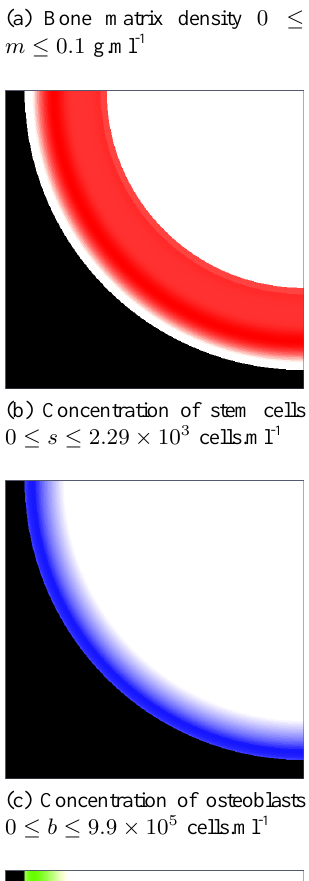
Fig. 3: One quarter of the domain where the black area corresponds to the bone ( m 0 ( x, y ) = 0 . 1 g.ml -1 ) and cellular cluster ( s 0 ( x, y ) = 10 6 cells.ml -1 and g 0 ( x, y ) = 2 × 10 3 ng.ml -1 ). Elsewhere, there is nothing initially.